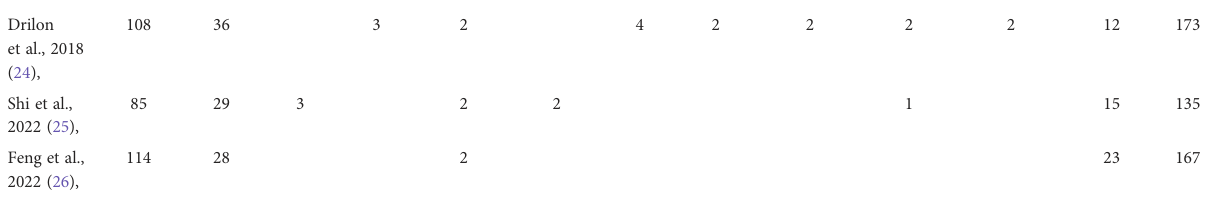
TABLE 1 Common RET gene fusion patterns.